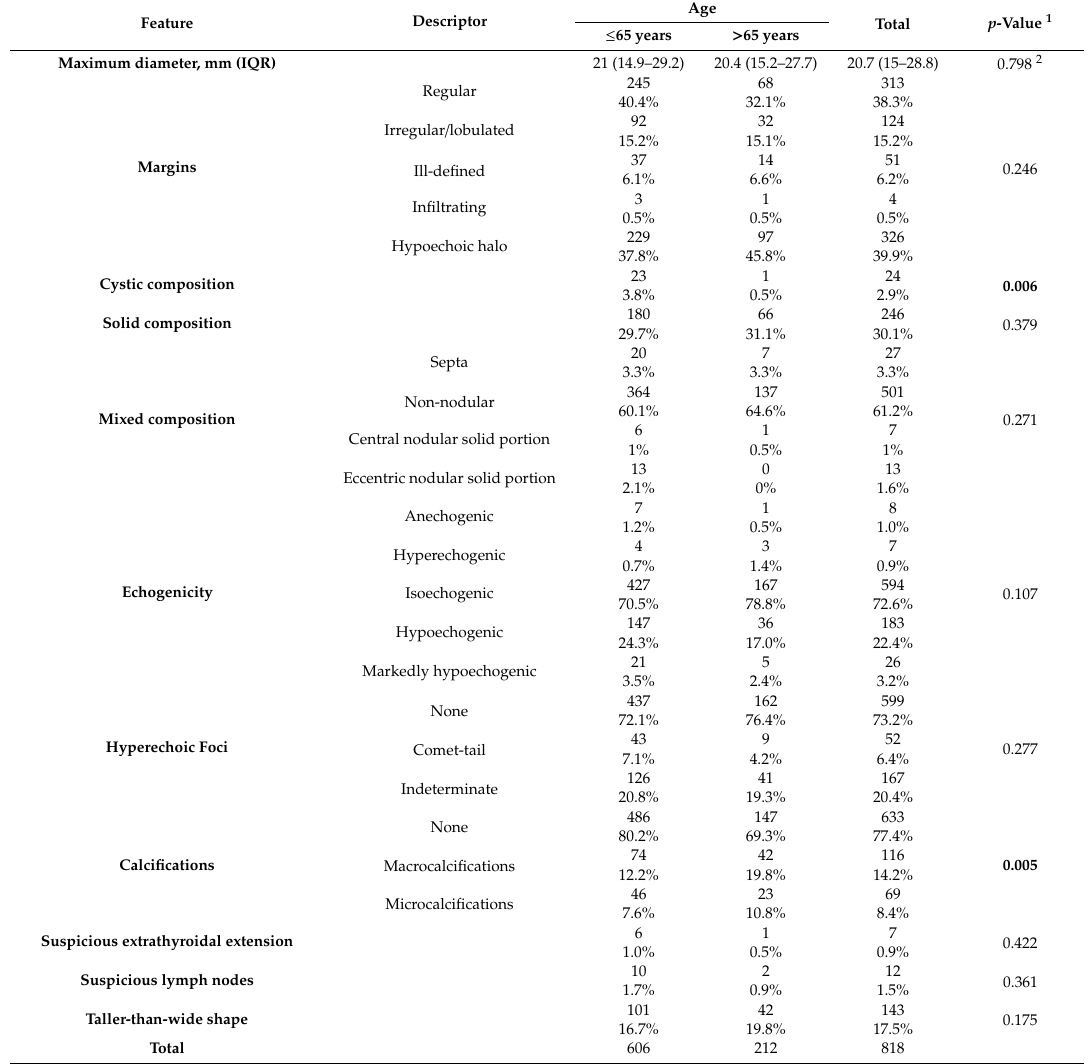
Table 1. Sonographic features of thyroid nodules according to age group.